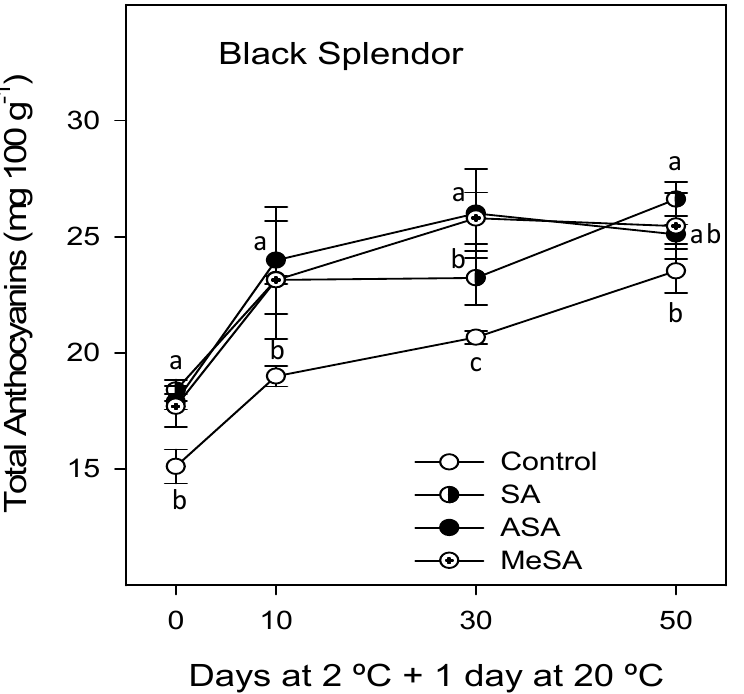
Figure 2. Total anthocyanin concentration in “Black Splendor” plums from control and salicylic acid (SA)-, acetyl salicylic acid (ASA)-, and methyl salicylic acid (MeSA)-treated trees at harvest and during storage at 2 ◦ C + 1 day at 20 ◦ C. Data are the mean ± SE of three replicates. Different lowercase letters show significant differences ( p < 0.05) among treatments for each sampling date.